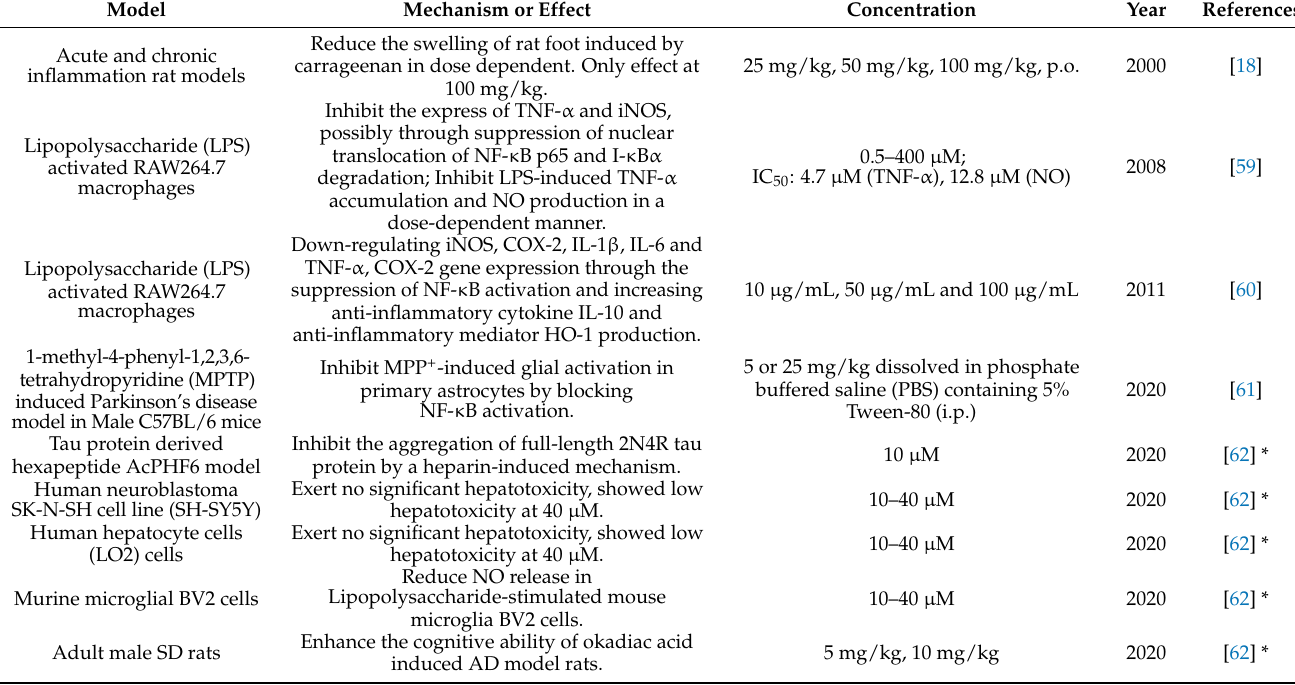
Table 1. Anti-inflammatory activities and mechanism of usnic